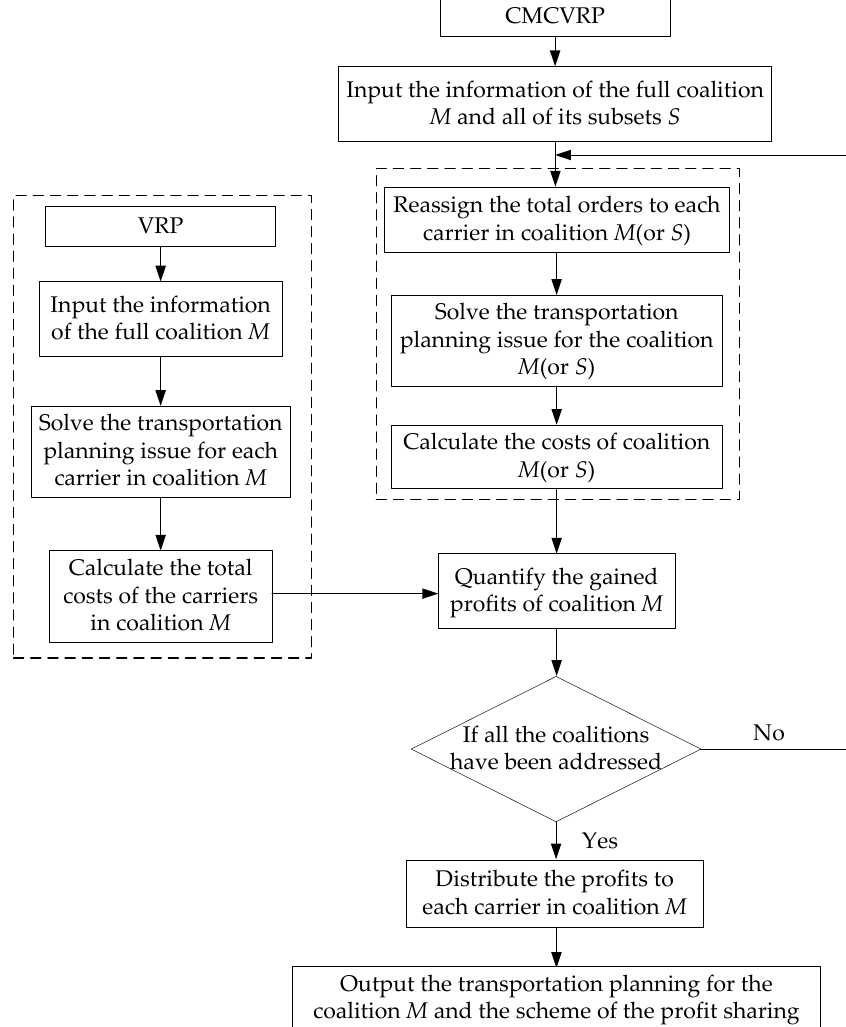
Figure 7. Solution framework for the CMCVRP.